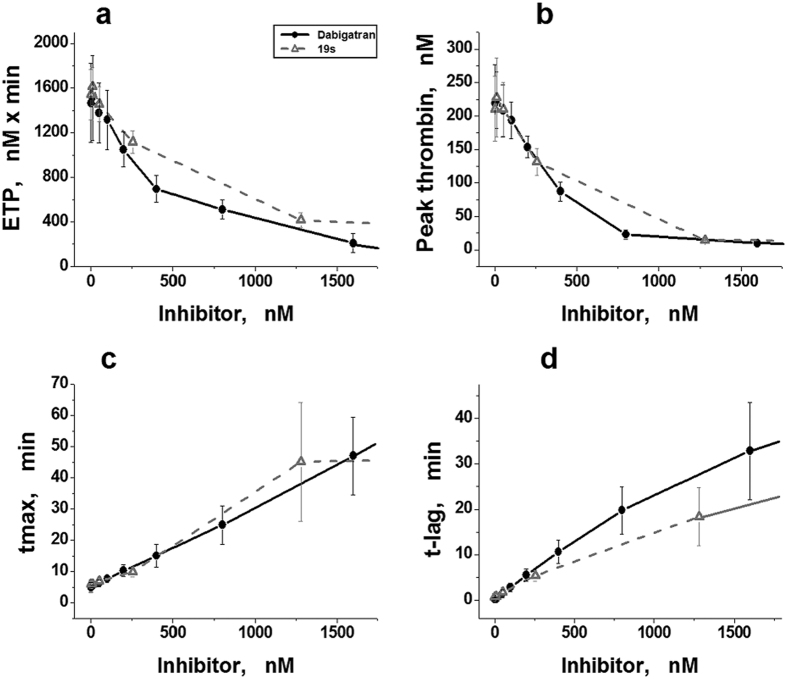
Parameters of TGT in donor plasma in the presence of DTIs, determined by a modified method using the calibration of signals by AMC fluorescence.(a–d) Endogenous thrombin potential (ETP), maximal thrombin concentration in the sample (peak thrombin), time to maximal concentration (tmax), and time to thrombin concentration 10 nM (t-lag) plotted against concentrations of dabigatran (•, black solid line) or the thrombin inhibitor 19s (Δ, grey dashed line). Mean values ± SD (n = 5) are presented. Different plasma sets were used in the groups of different inhibitors, but they were the same as in the groups presented in Fig. 2.